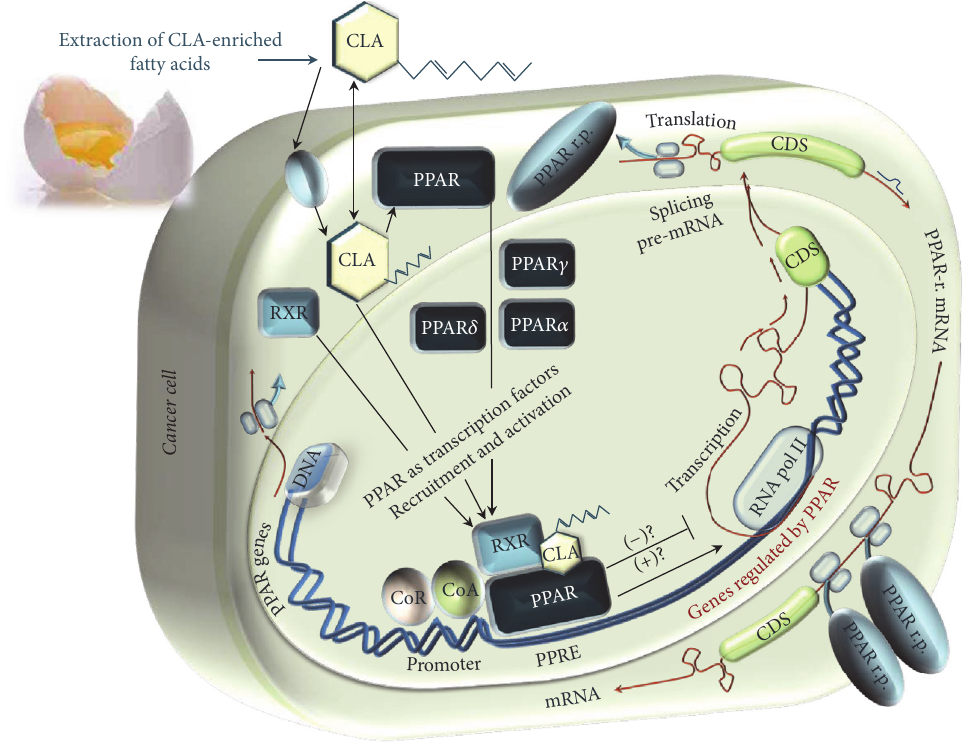
Figure 5: Molecular aspects of CLA-induced accumulation of PPAR-responsive transcripts. PPAR-r. mRNA: PPAR-regulated mRNAs; PPAR- r.p.: PPAR-regulated proteins; PPRE: peroxisome proliferator hormone response element (AGGTCANAGGTCA); RXR: retinoid X receptor; ORF: open reading frame (coding